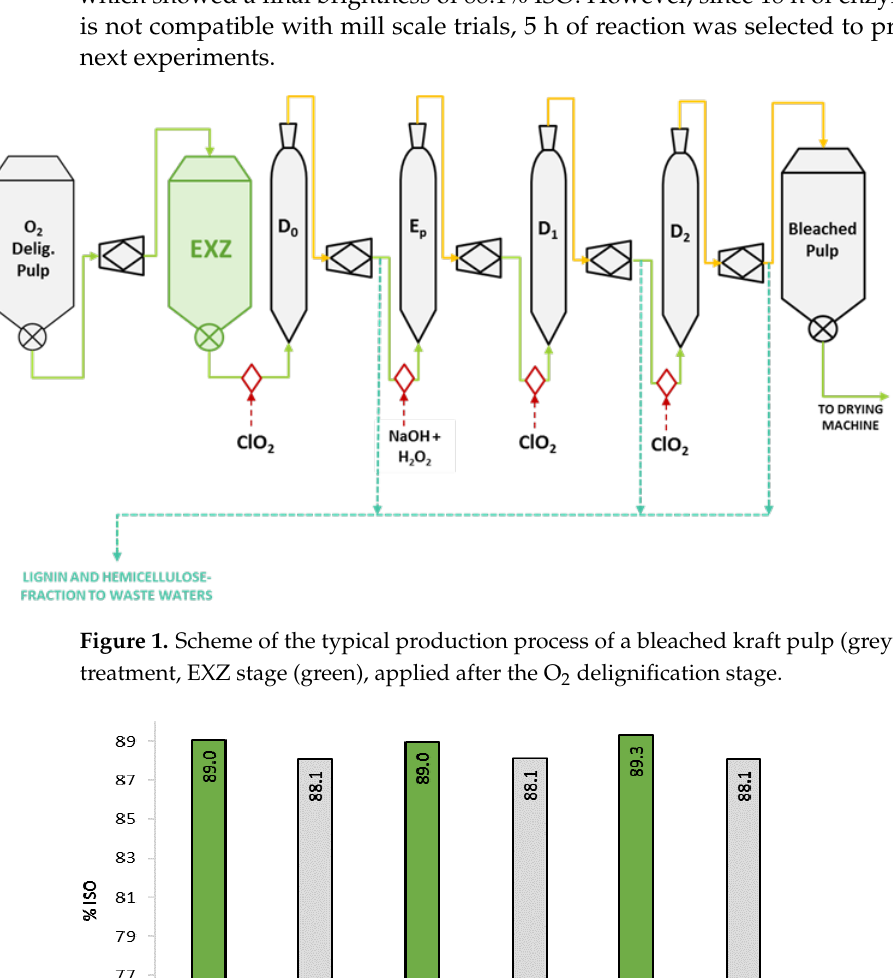
Figure 2. Final pulp brightness (after D 2 ) obtained through Xyn11 pretreatment for 3, 5 and 18 h, followed by a full bleaching sequence, compared to the corresponding control sequences.